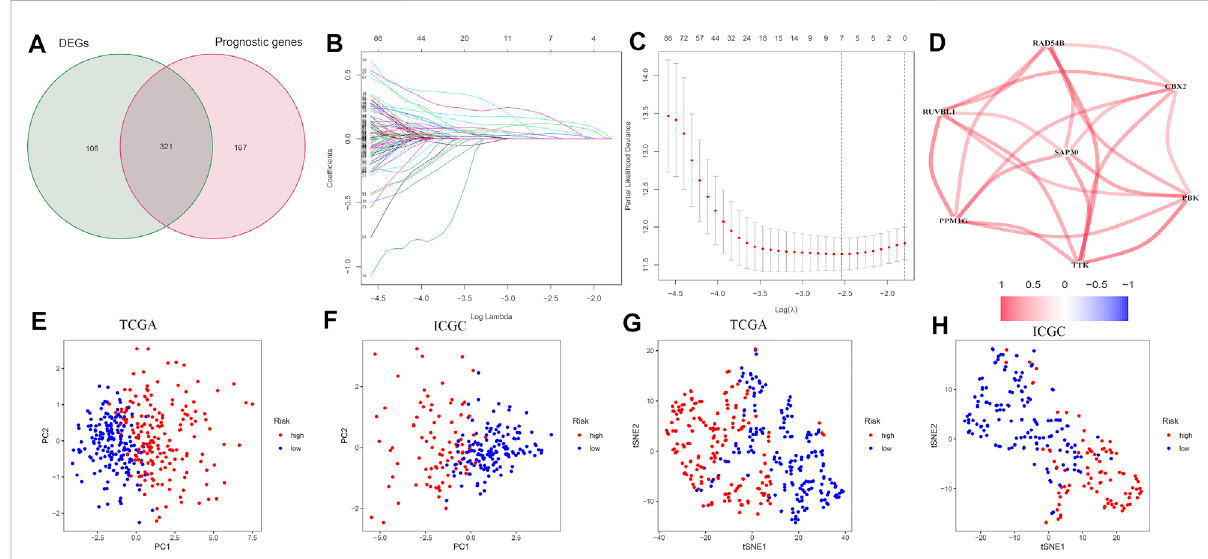
FIGURE 1 Development of the CR-based prognostic risk score model in the training set. (A) Venn diagram for tumor and normal tissue adjacent to carcinomaofdifferentiallyexpressedgenesrelatedtotheOS. (B) LASSOcoef fi cientsofsevenCRs. (C) Identi fi cationofCRsfordevelopingprognostic risk scoring models. (D) Correlation network of the CRs that makes up the model. Red lines indicate a positive correlation. (E – H) PCA and t-SNE assays based on chromatin regulator risk score to distinguish tumors from normal samples in the TCGA cohort and ICGC cohort. The low-risk patients are marked with green groups, and the high-risk patients are marked with red